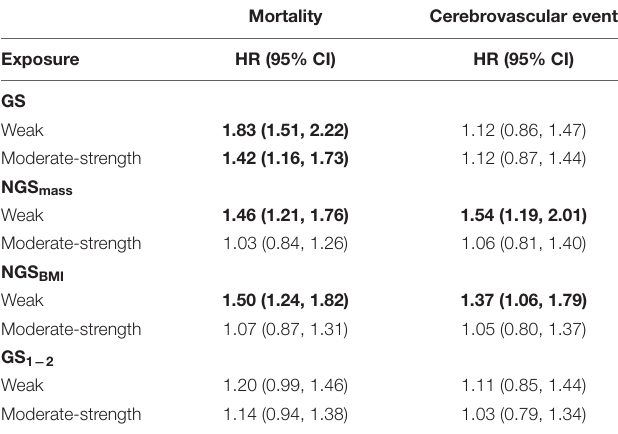
TABLE 2 | Cox proportional hazards regression for the association between sex- and age group-specific tertiles for grip strength (GS) measures (reference group: strong tertile) with mortality ( n = 4,143) and cerebrovascular event ( n =